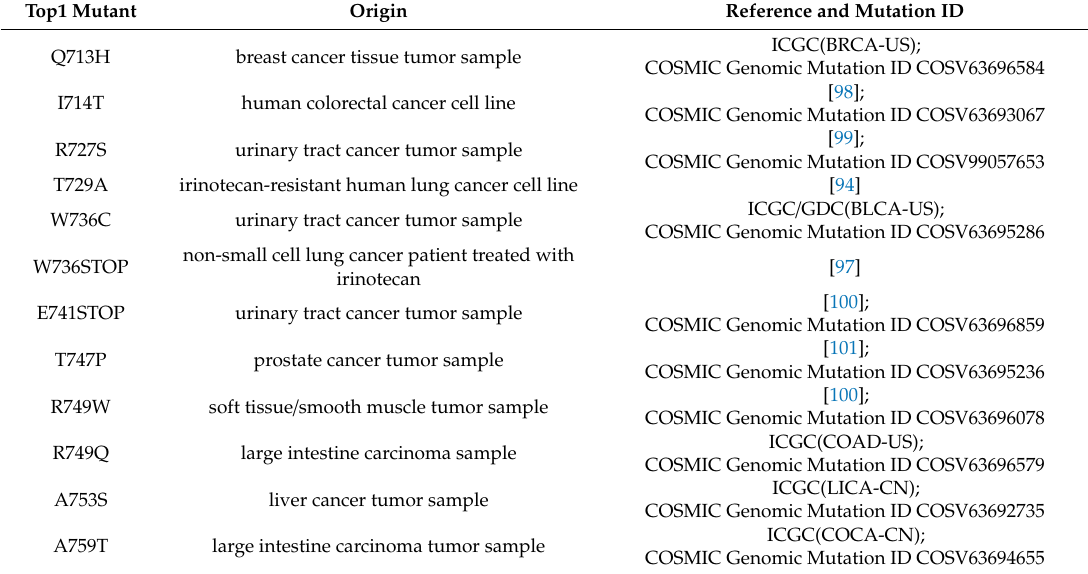
Table 2. A selected list of human Top1 C-terminal mutations from studies, cancer cell lines, and patient